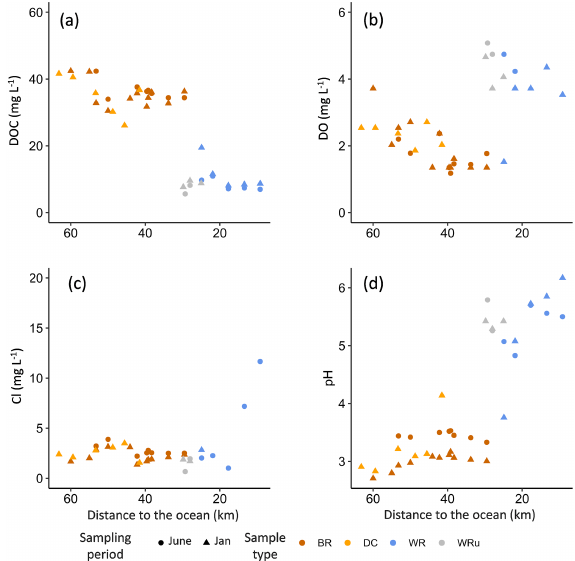
Figure 2. Evolution of (a) dissolved organic carbon (DOC) con- centration, (b) dissolved oxygen (DO) concentration, (c) chloride concentration and (d) pH along the continuum from the blackwater river to the